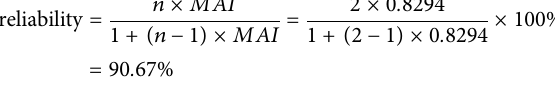
TABLE 3 Analysis of necessary